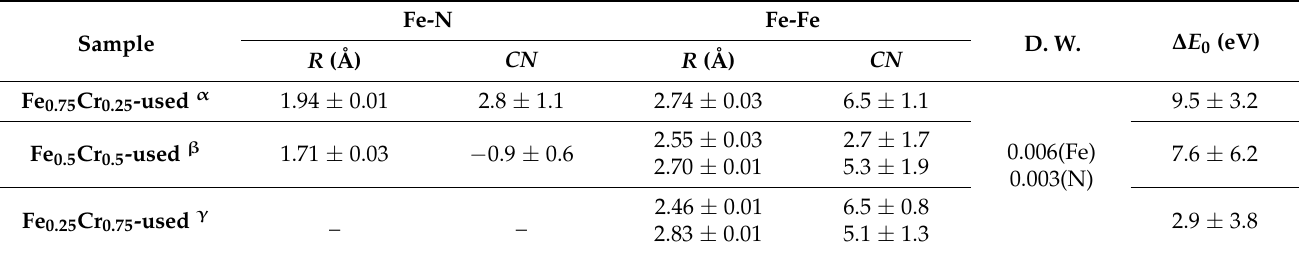
Table 4. Fe K edge EXAFS fitting results of used FeCrO x catalysts a .